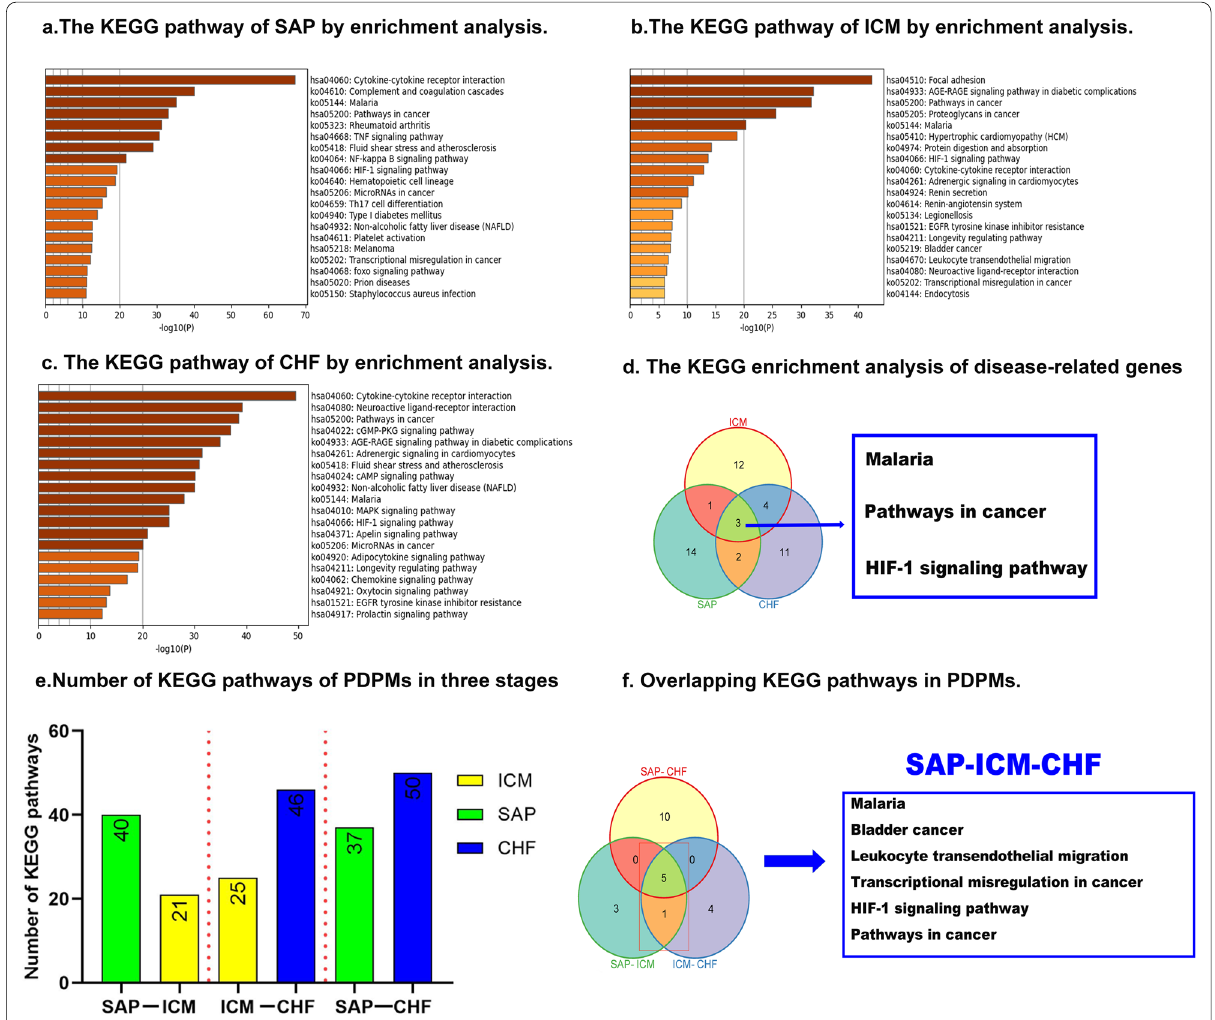
Fig. 5 The KEGG pathways enrichment analyses of disease‑related genes and PDPMs. a Top 20 KEGG pathways enrichment analysis of SAP‑related genes. b Top 20 KEGG pathways enrichment analysis of ICM‑related genes. c Top 20 KEGG pathways enrichment analysis of CHF‑related genes. d Overlapping KEGG pathways of three disease‑related genes. e Number of KEGG pathways of modules in three stages. f Overlapping KEGG pathways in